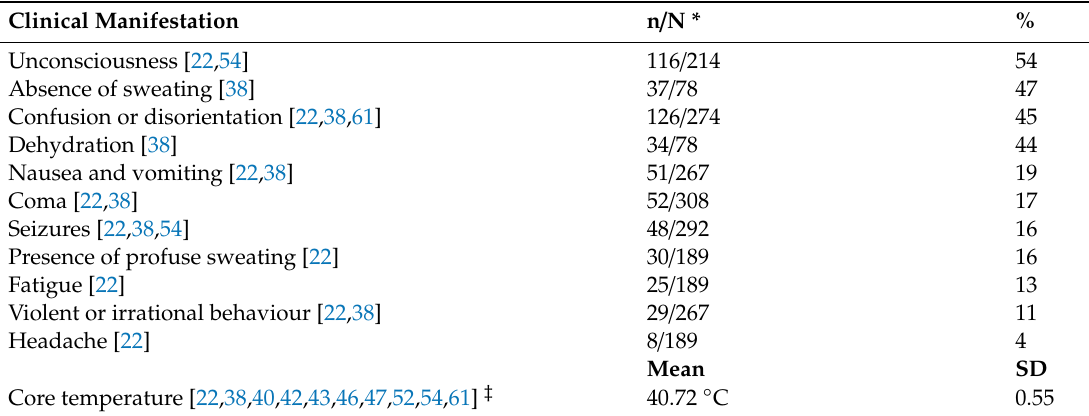
Table 4. Clinical manifestations of exertional heat stroke in the military.